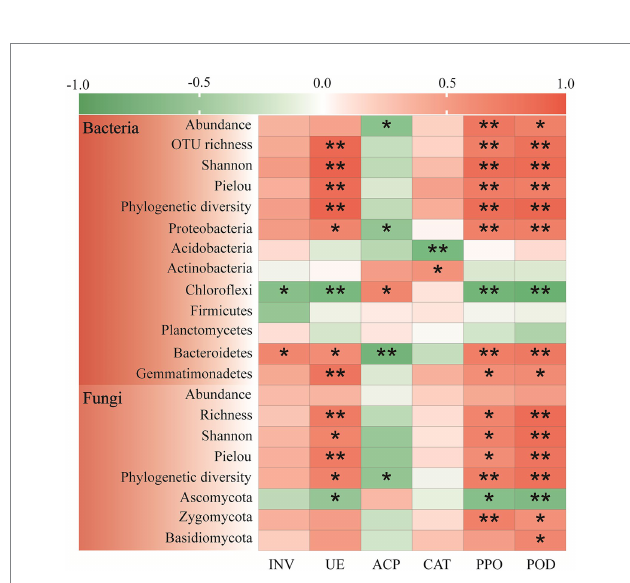
FIGURE 5 Pearson correlation heat maps between soil bacterial, fungal community composition (abundance, alpha-diversity and dominant phyla) and enzyme profiling in the Cinnamomum camphora coppice planting. Red represents a positive correlation, and green represents a negative correlation. (* p < 0.05; ** p <